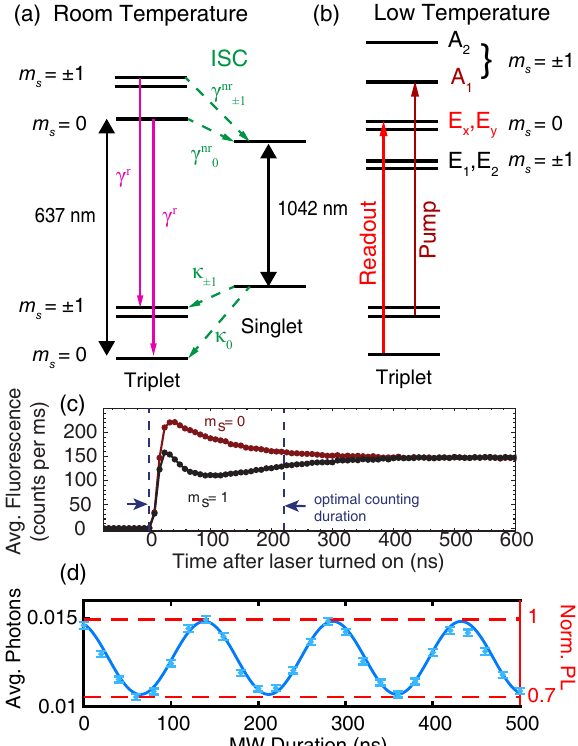
Figure 1. The diamond NV center. ( a ) Room temperature electronic structure. Solid lines indicate radiative transitions (with corresponding rate γ r ), and dashed lines represent nonradiative intersystem crossing (ISC) transitions (with rates γ r and κ i for the excited and ground-state spin projection i , i respectively). Solid black arrows represent the zero phonon lines of the triplet and singlet manifolds. ( b ) Low temperature electronic structure of the nitrogen-vacancy (NV) center triplet manifold. Individual transitions used for spin pumping and resonant readout are indicated. ( c ) Room temperature transient fluorescence response for the spin states m s = 0,1 produced by 532nm illumination. The optimal counting duration is indicated by the dashed vertical lines. Reprinted with permission from [42], Optical Society of America. ( d ) Rabi nutations of the ground-state spin at room temperature, measured using traditional PL readout for an NV center beneath a planar diamond surface, with an NA = 0.9 objective. The left and right axes plot the average detected photons per measurement and normalized PL, respectively. The solid curve is a fit to the